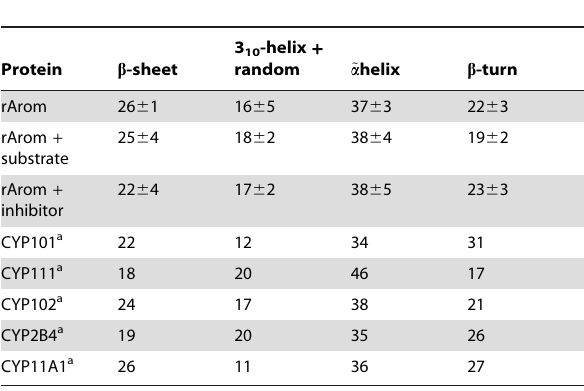
Table 1. Amount of secondary structure elements (%) present in rArom and comparison with the values reported in literature for other P450 enzymes.